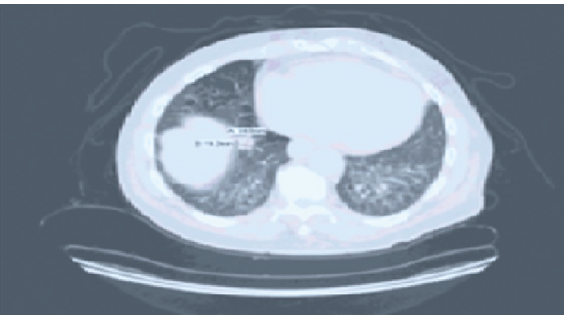
Figure 2: CT chest with contrast showing 1.4cm right lower lobe lung nodule.